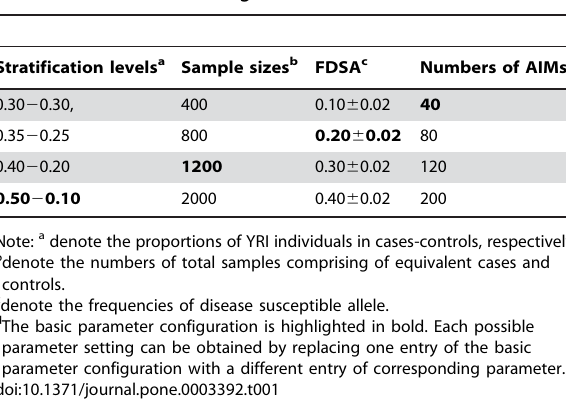
Table 1. Parameter configurations in the simulation